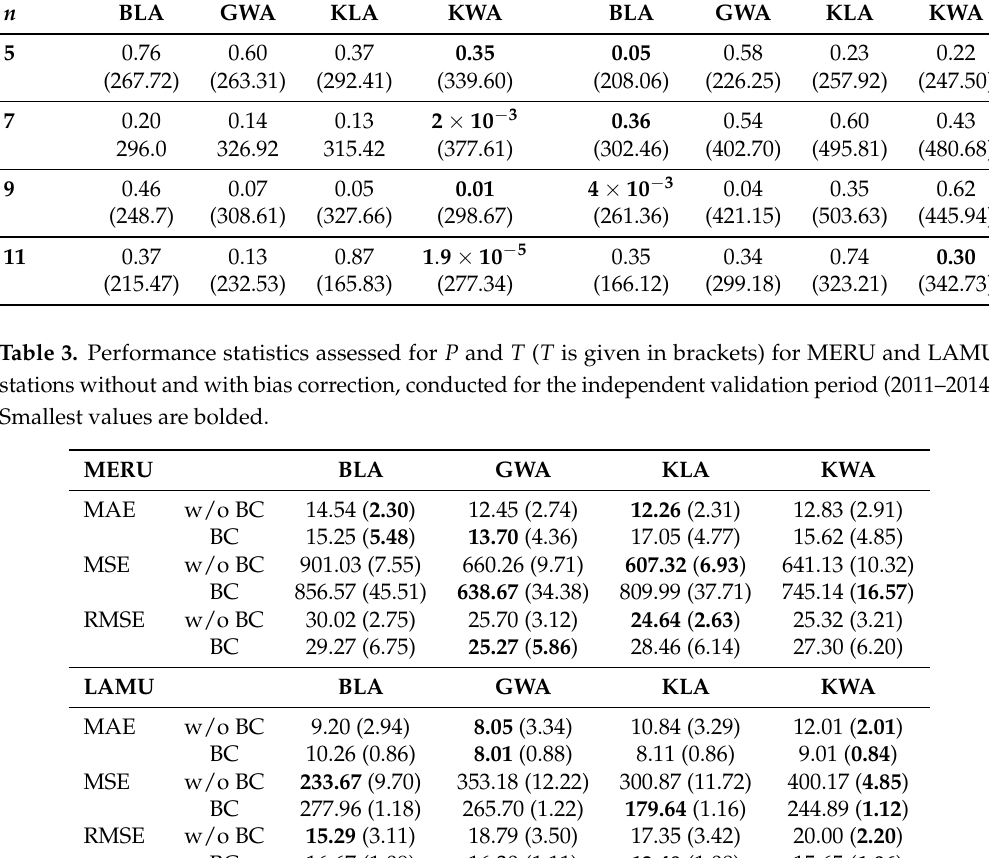
Table 2. p - and χ 2 -values (brackets) of χ 2 -tests for MERU and LAMU stations (2005–2009), conducted for various lattice dimensions n × n . Smallest values are bolded. MERU LAMU